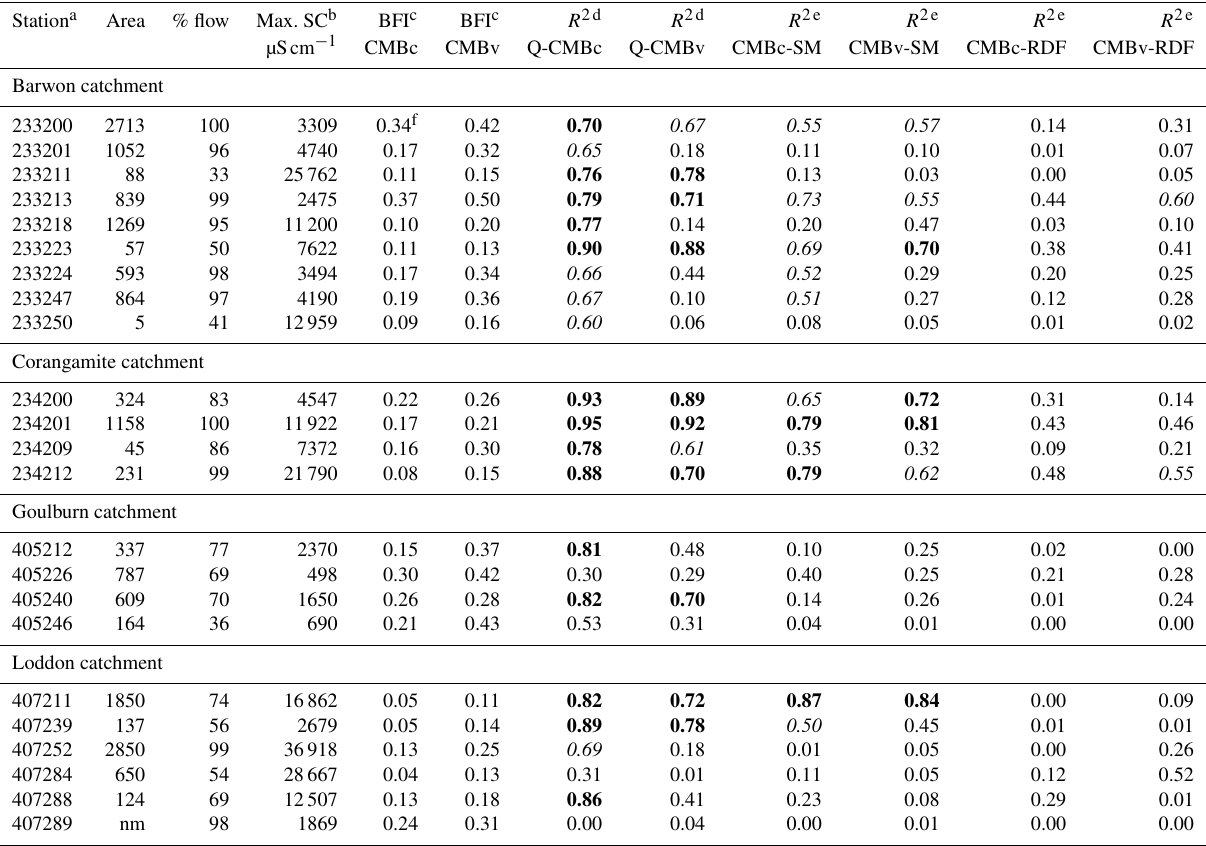
Table 1. Summary of baseflow estimates from south-eastern Australia. Station